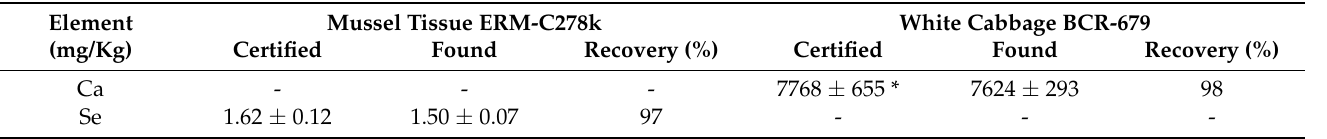
Table 1. Analysis of certified references materials (mean ± standard